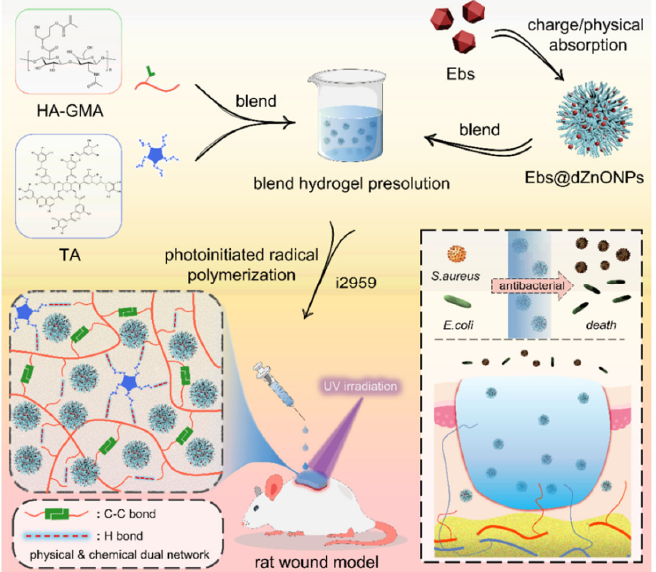
Figure 1. Schematic diagram of preparation of Ebs@dZnONPs/HGT hydrogel and its application in the treatment of infected wounds.